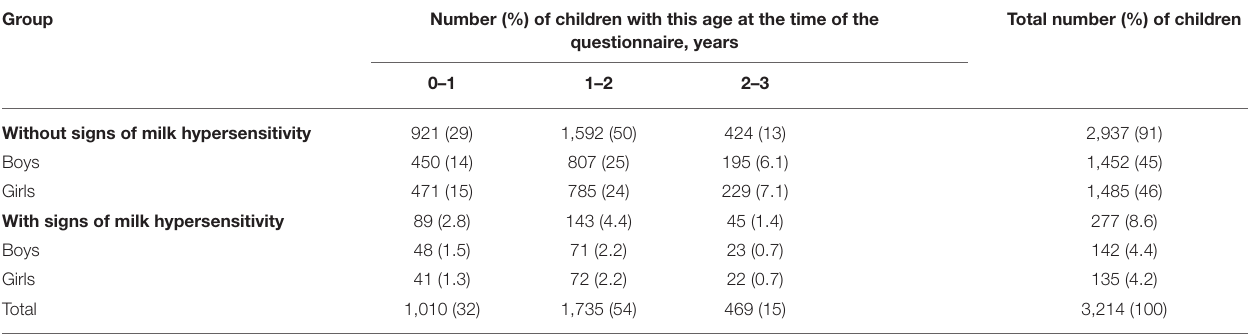
TABLE 4 | Distribution of children by age and food hypersensitivity to milk. Group